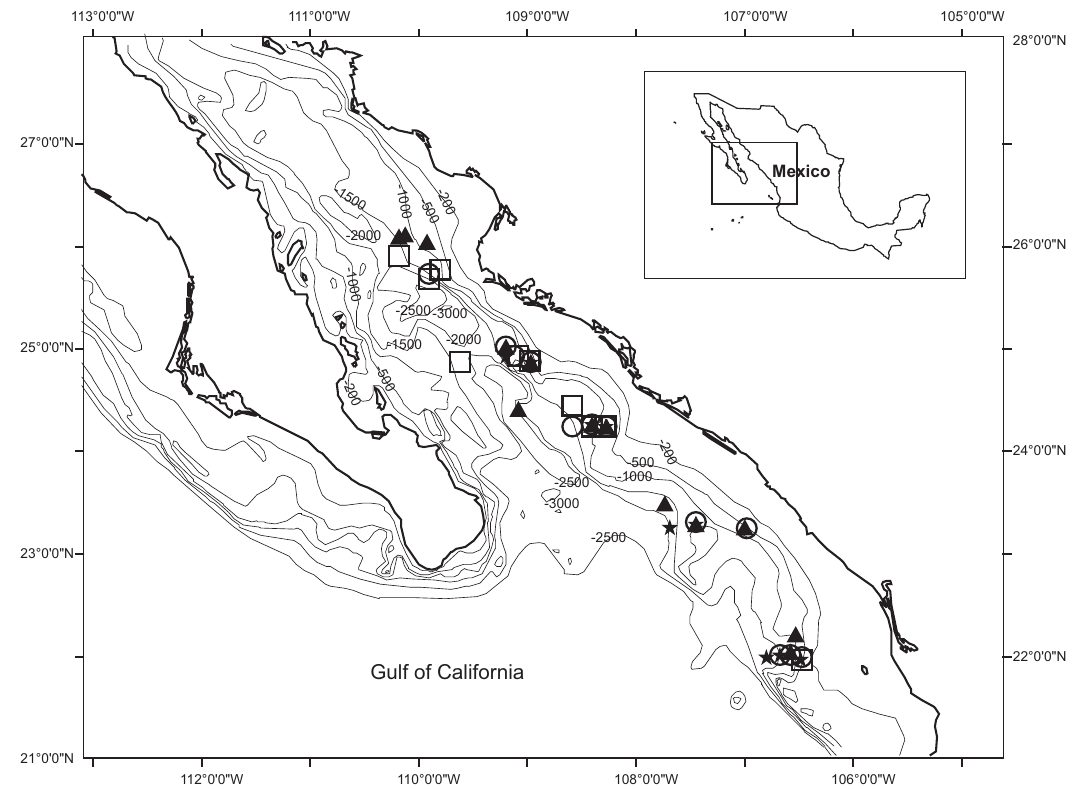
F IG . 1. – Study area showing the location of stations (TALUD 4= squares; TALUD 5= asterisks; TALUD 6= circles; TALUD 7=